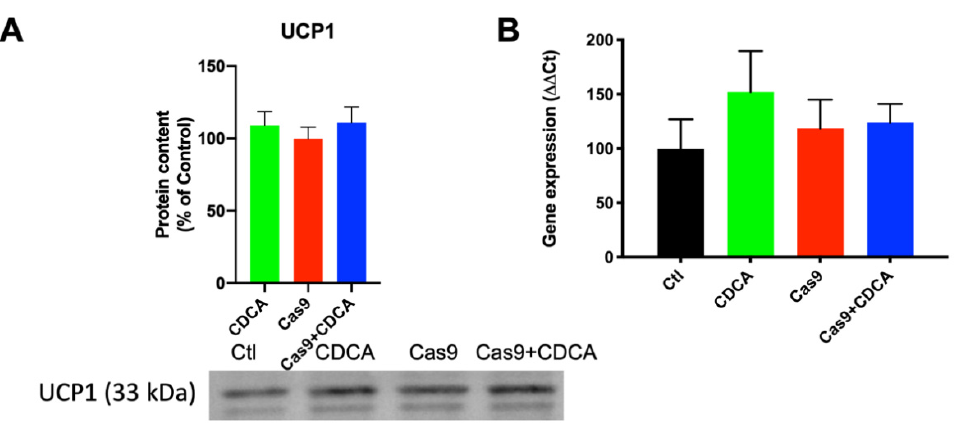
Figure 3. UCP1 levels in 3T3-L1 adipocytes exposed to CDCA, in the absence or presence of TGR5. ( A ) Representative Western Blot for UCP1 and respective quantification; ( B ) Gene expression for ucp1 . Data are derived from seven independent experiments, and bars represent means ± SEM (no statistical differences were found).